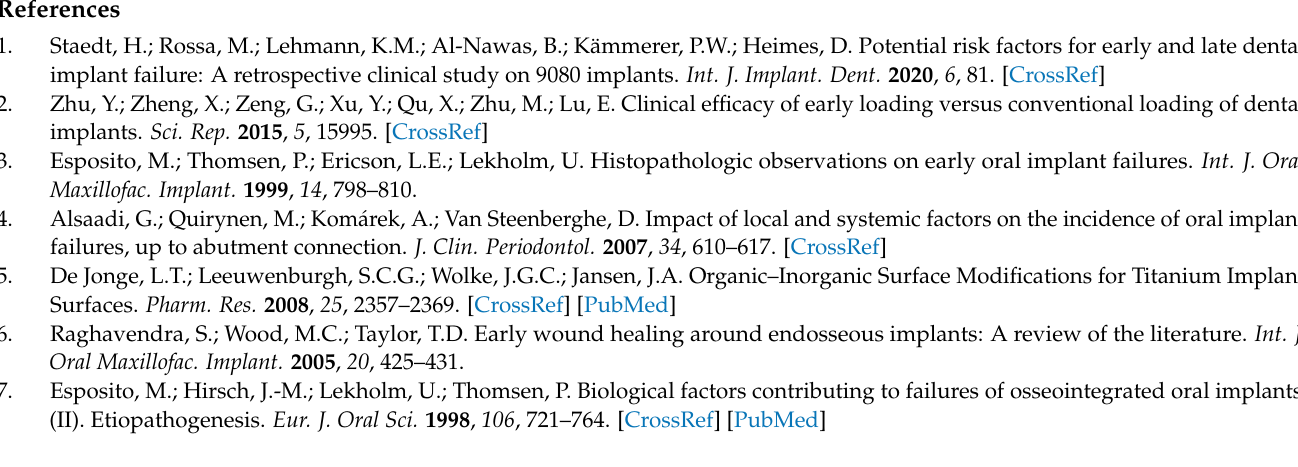
data); Figure S3: Sensitivity Analysis Network Plot: Implant failure (per implant data); Figure S4: Network plot: Prosthetic failure (Patient); Figure S5: SUCRA ranking curve for Prosthetic Failure (Patient); Figure S6: League table for Prosthetic Failure (Patient); Figure S7: Pairwise meta-analysis for Prosthetic Failure (Patient); Figure S8: Network plot: Postsurgical Complications; Figure S9: SUCRA ranking curve for Postsurgical Complications; Figure S10: League table for Postsurgical Complication; Figure S11: Pairwise meta-analysis for Postsurgical complications; Figure S12: Network plot: Adverse Effect; Figure S13: SUCRA ranking curve for Adverse Effect; Figure S14: League table for Adverse Effect; Figure S15: Pairwise meta-analysis for Adverse Effects; Figure S16: Comparison- adjusted funnel plot for Implant failure (Patient); Figure S17: Comparison-adjusted funnel plot for Implant failure (per implant data); Figure S18: Comparison-adjusted funnel plot for prosthetic failure; Figure S19: Comparison-adjusted funnel plot for postsurgical complications; Figure S20: Comparison-adjusted funnel plot for adverse effects; Table S1: Abbreviations; Table S2: Risk of bias assessment of included studies; Table S3: Results of network meta-analysis from sensitivity analysis: implant failure (per patient data); Table S4: Results of network meta-analysis: Prosthetic failure (Patient); Table S5: Results of network meta-analysis: Postsurgical Complications; Table S6: Results of network meta-analysis: adverse effect; Table S7: Network consistency for implant failure